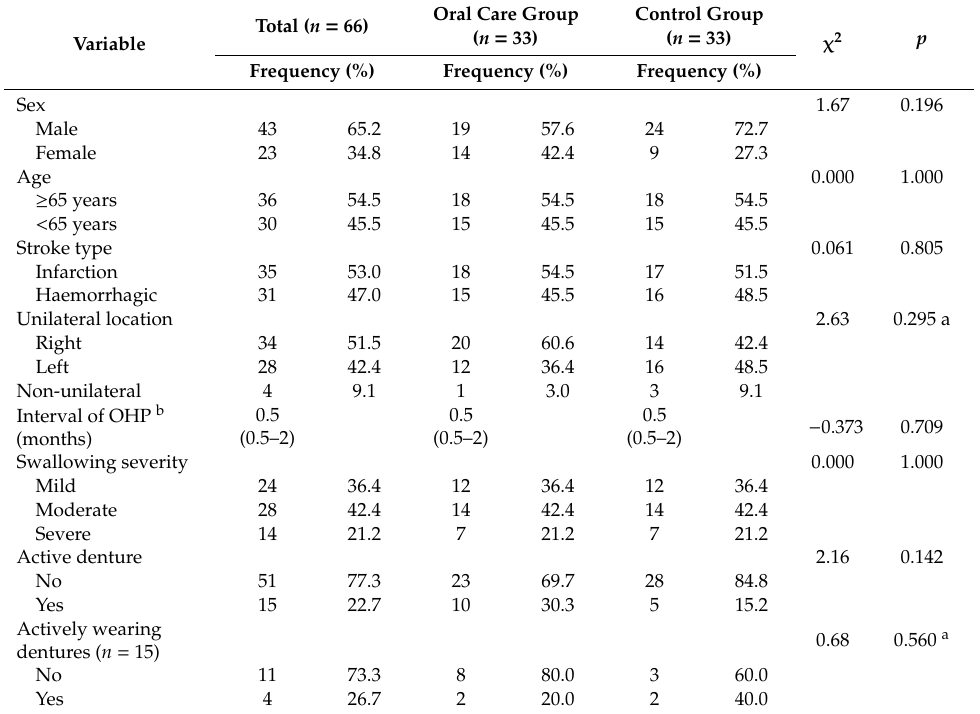
Table 1. Baseline characteristics of the oral care and control